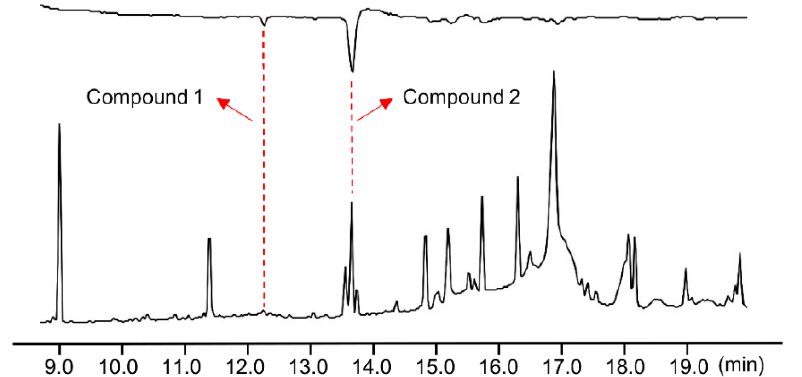
Figure 2. Gas chromatography–electroantennographic detector (GC–EAD) recording of Archips strojny male moth antennal responses to female crude gland extract (upper: EAD, lower: GC). Two com- ponents (Compounds 1 and 2) from the A. strojny female pheromone gland extract with retention times of 12.25 min and 13.67 min, respectively, were detected from active responses by the male moth